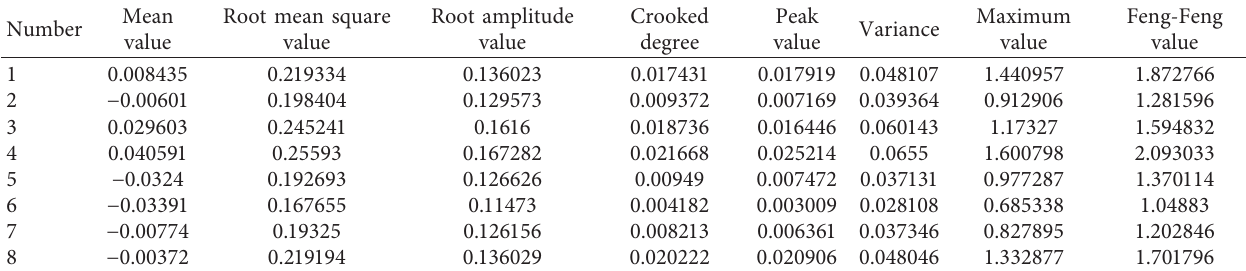
Table 2: Some of the dimension time-domain